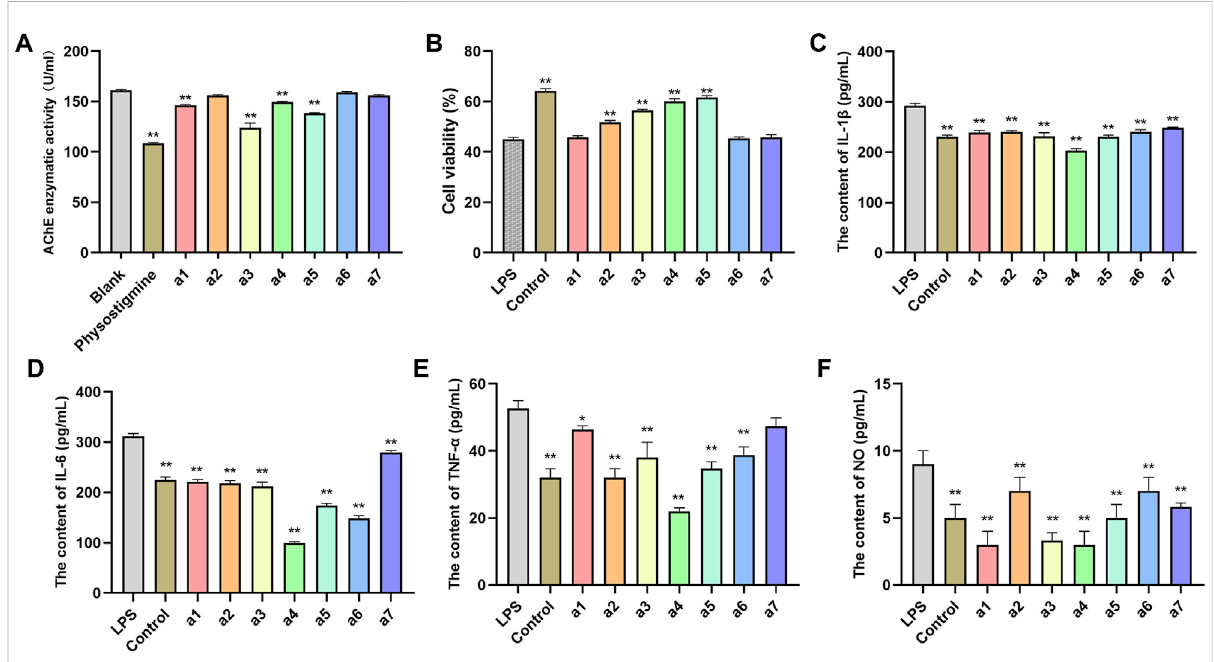
FIGURE 8 In vitro validation of 7 compounds. (A) Inhibitory effects of 7 compounds on AChE in PC12 cells. (B) Effects of 7 compounds on the viability of PC12cells.Effectof7compoundsontheproductionofIL-1 β (C) ,IL-6 (D) ,TNF- ɑ (E) ,andNO (F) inLPS-inducedPC12cells. Theresultsrepresentthe mean ± SEM ( n = 3), vs. LPS * p < 0.05, ** p < 0.01.